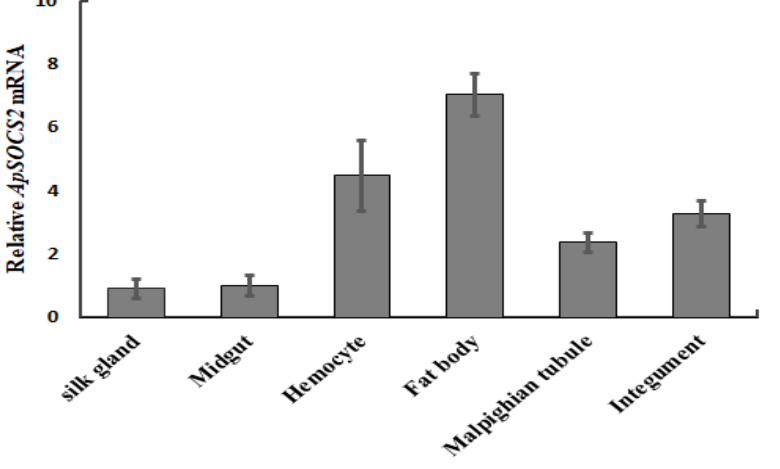
Figure 4. Expression profile of ApSOCS-2 in various tissues of A. pernyi normalized to 18 S and actin-1 (Actin-1 normalized: Figure S2). The mRNA expression profile of ApSOCS-2 in various tissues of the A. pernyi was determined using qRT-PCR. The values are represented as mean ± S.E.